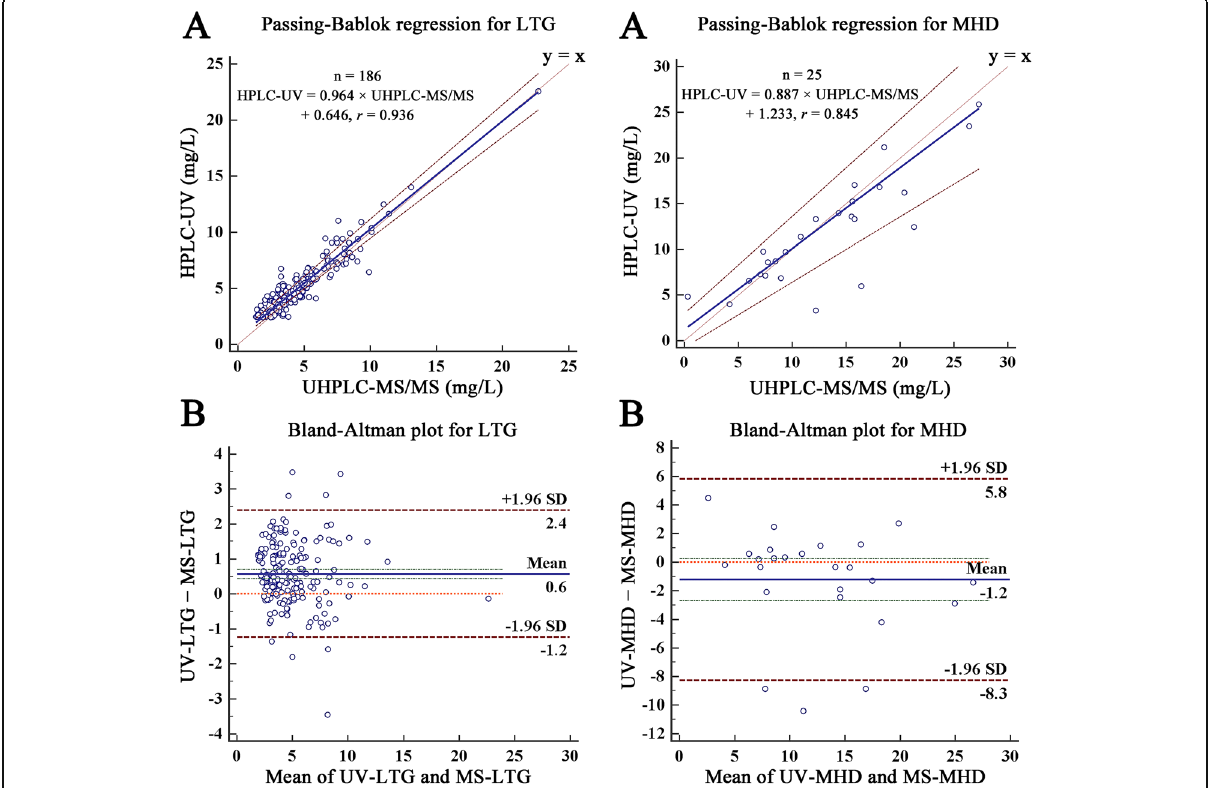
Fig. 2 Passing-Bablok regression and Bland-Altman plot of UHPLC-MS/MS and HPLC-UV methods in the analysis of LTG and MHD in human plasma. a Passing-Bablok regression. b Bland-Altman plot. The green line in b was 95% confidence interval of the mean